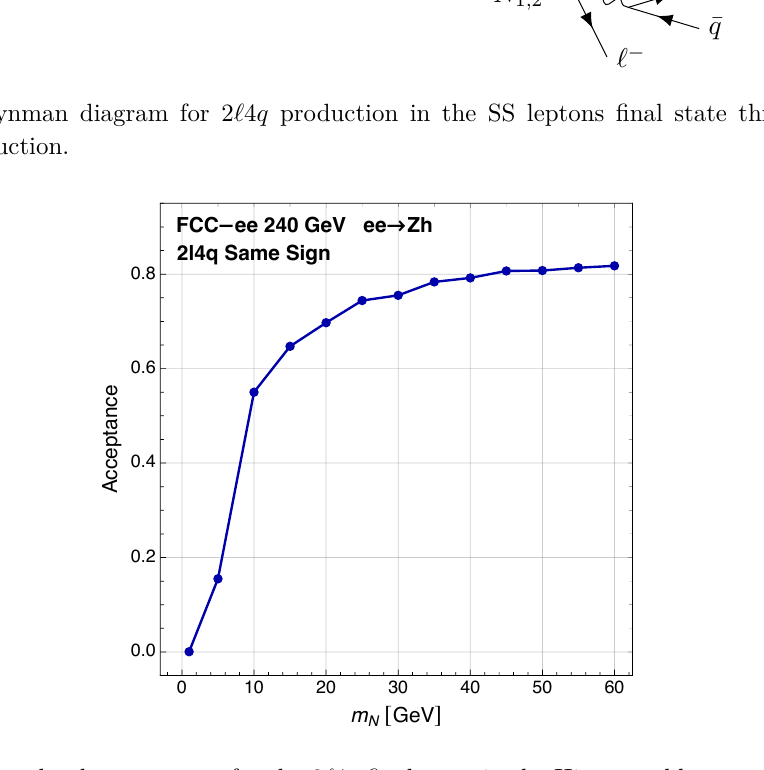
Figure 4 . Parton level acceptances for the 2 ‘ 4 q final state in the Higgs-strahlung topology with a leptonically decaying Z boson and with the selection cuts described in the main